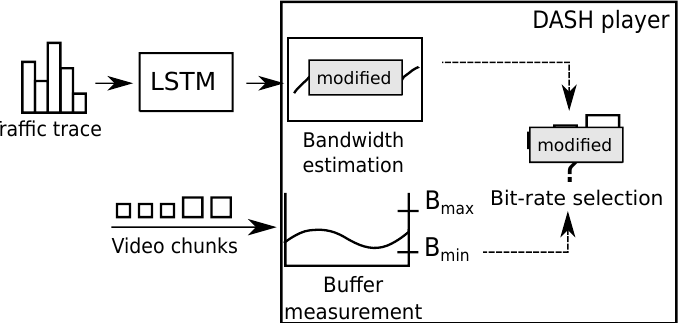
Figure 11. The architecture of the dash.js reference player. The modified estimation module ac- quires information about network throughput from the LSTM ANN. The MSS, ExoPlayer and Tian algorithms replaced the player’s default playback